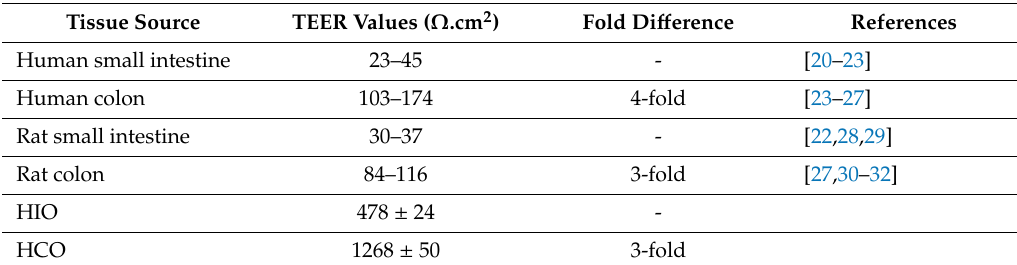
Table 1. Comparison of HIO- and HCO-derived epithelium TEER and published values from human and rat small and large intestinal